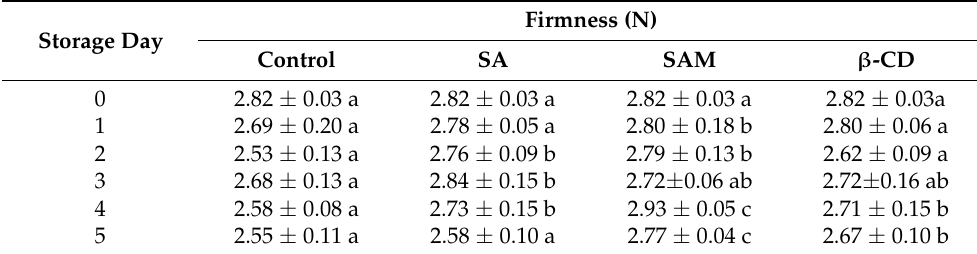
Table 1. Effect of SAM on ‘Fuji’ apple firmness during 5 days of storage at 25 °C.